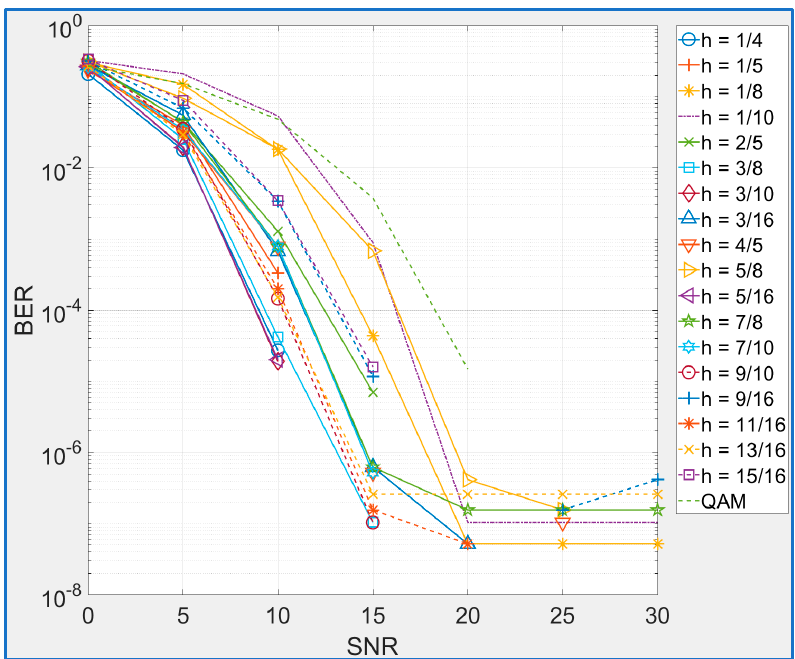
Figure 11. BER performance of CPM-GFDM vs. QAM-GFDM with J = 8 for zero forcing receiver over AWGN channels.